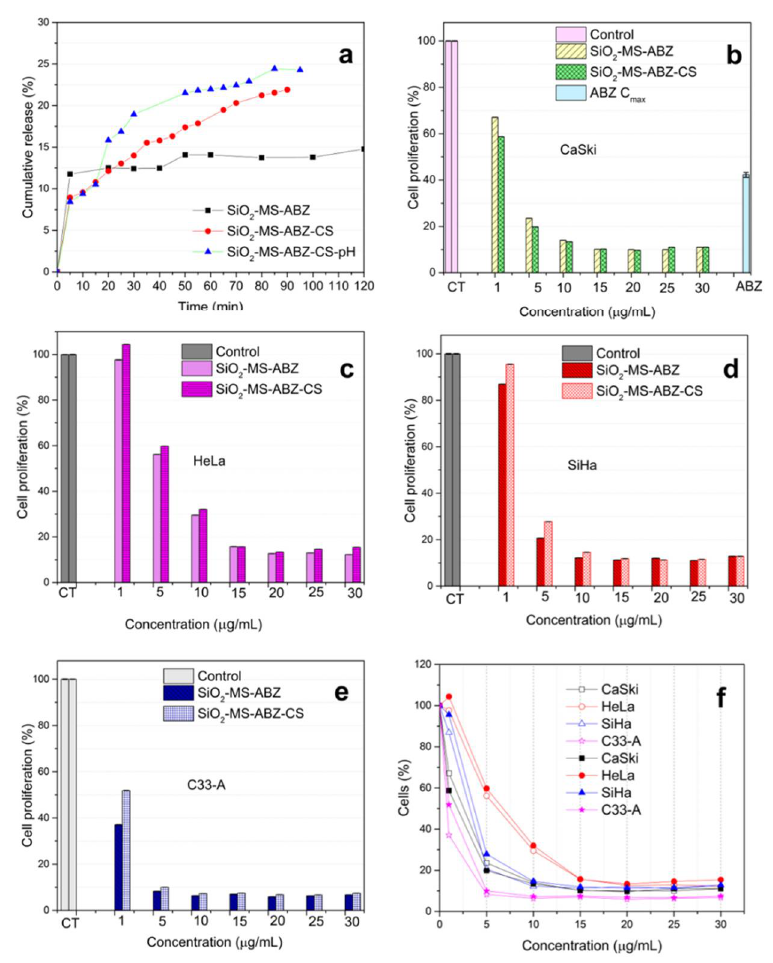
Figure 7. ( a ) Drug release profiles from uncoated and coated mesoporous silica; pH was adjusted with HCl until 4.8 value was reached (t = 30 min), and cell proliferation determined by crystal violet after 72 h of incubation with different doses of nanoparticles ( b ) CaSki, ( c ) HeLa, ( d ) SiHa and ( e ) C33-A cell lines. The percentages are the result of three replicates; the bars indicate estimated error. Additionally, ( f ) shows the comparison; ( b – e ) the hollow symbols represent the results obtained for uncoated particles, whereas the filled ones correspond to chitosan-coated materials.